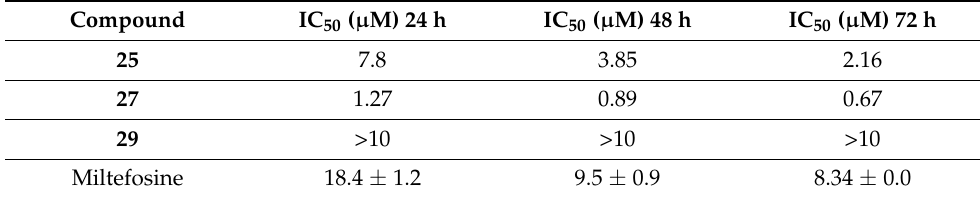
Table 2. In vitro evaluation of the antiparasitic activity against T. cruzi epimastigotes (Y strain) after incubation for 24 h, 48 h or 72 h.